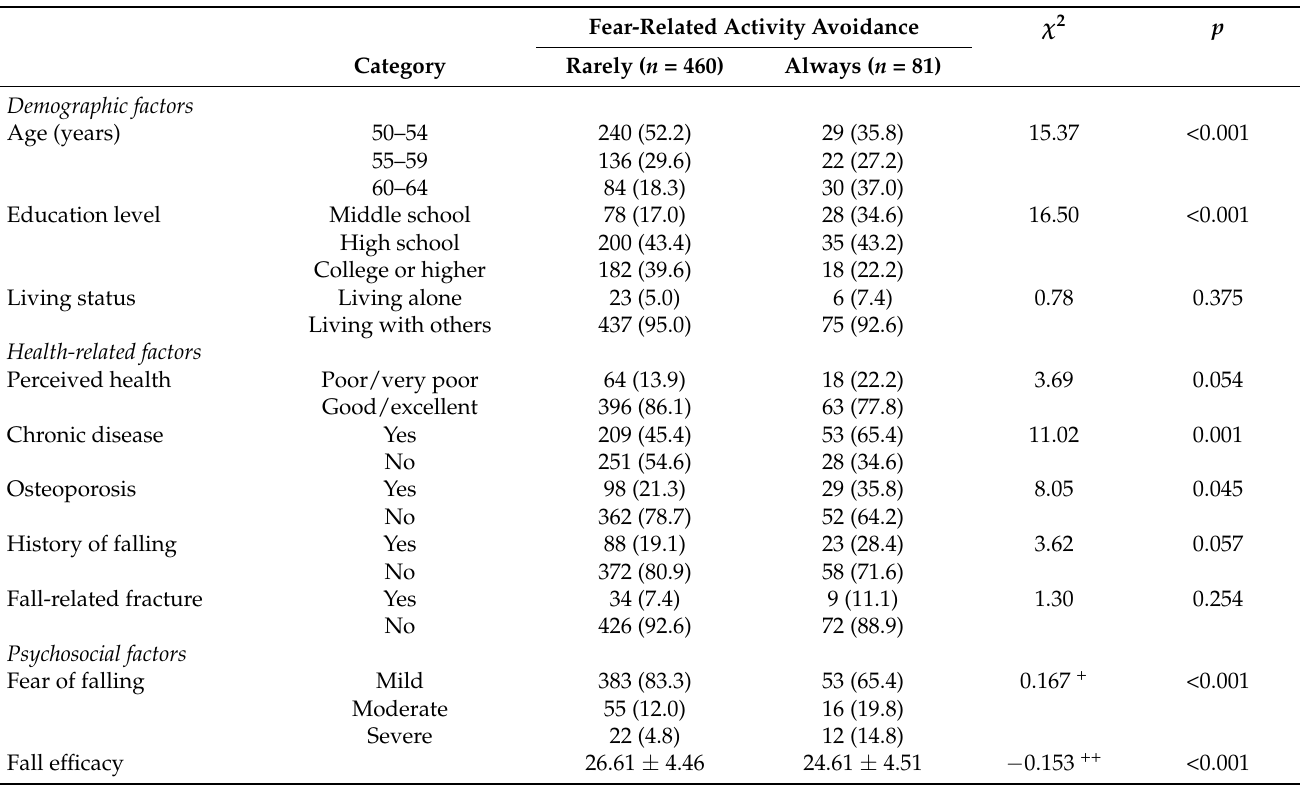
Table 2. General characteristics of the participants according to degree of fear-related activity avoidance ( N = 541). Fear-Related Activity Avoidance